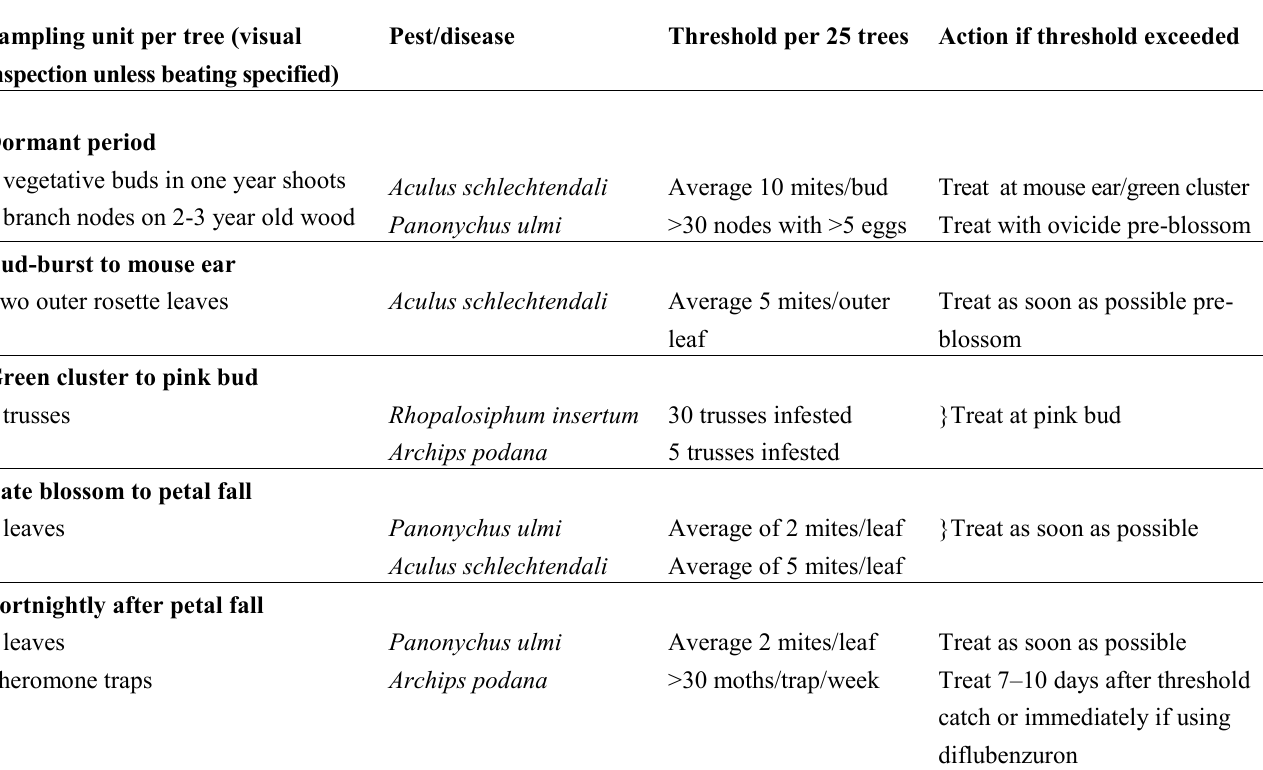
Table 1. Agricultural Development and Advisory Service (ADAS) economic thresholds used for the pest species found in Northern Irish apple orchards